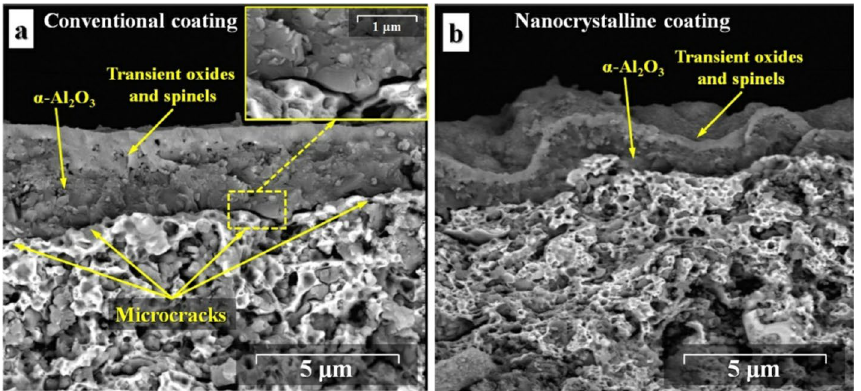
Figure 18. Cross-sectional FESEM image of the oxide scale formed on ( a ) conventional and ( b ) nanocrystalline MCrAlY coatings obtained by 15 h milled powder feedstock under thermal cycling test under 1100 °C after 300